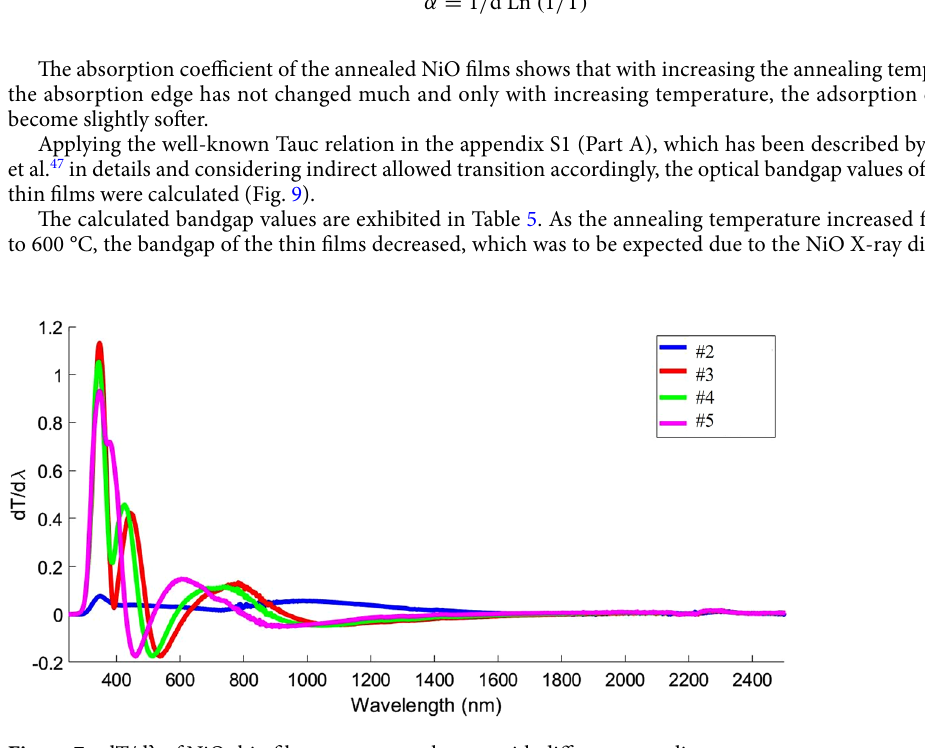
Figure 7. dT/dλ of NiO thin films on quartz substrate with different annealing temperatures.